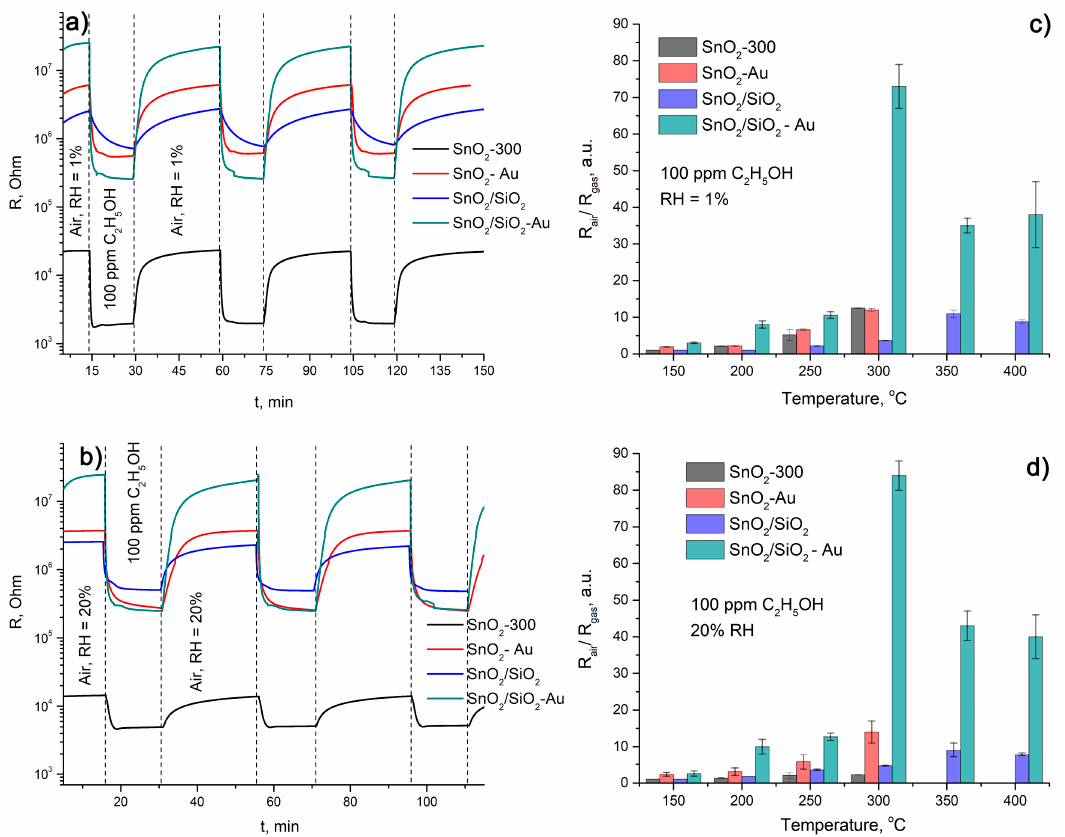
Figure 7. Change in the sample resistance at 300 ◦ C in the presence of 100 ppm C 2 H 5 OH in dry air ( a ) and at RH = 20% ( b ). Temperature dependence of the sensor response in dry air ( c ) and at RH = 20% ( d